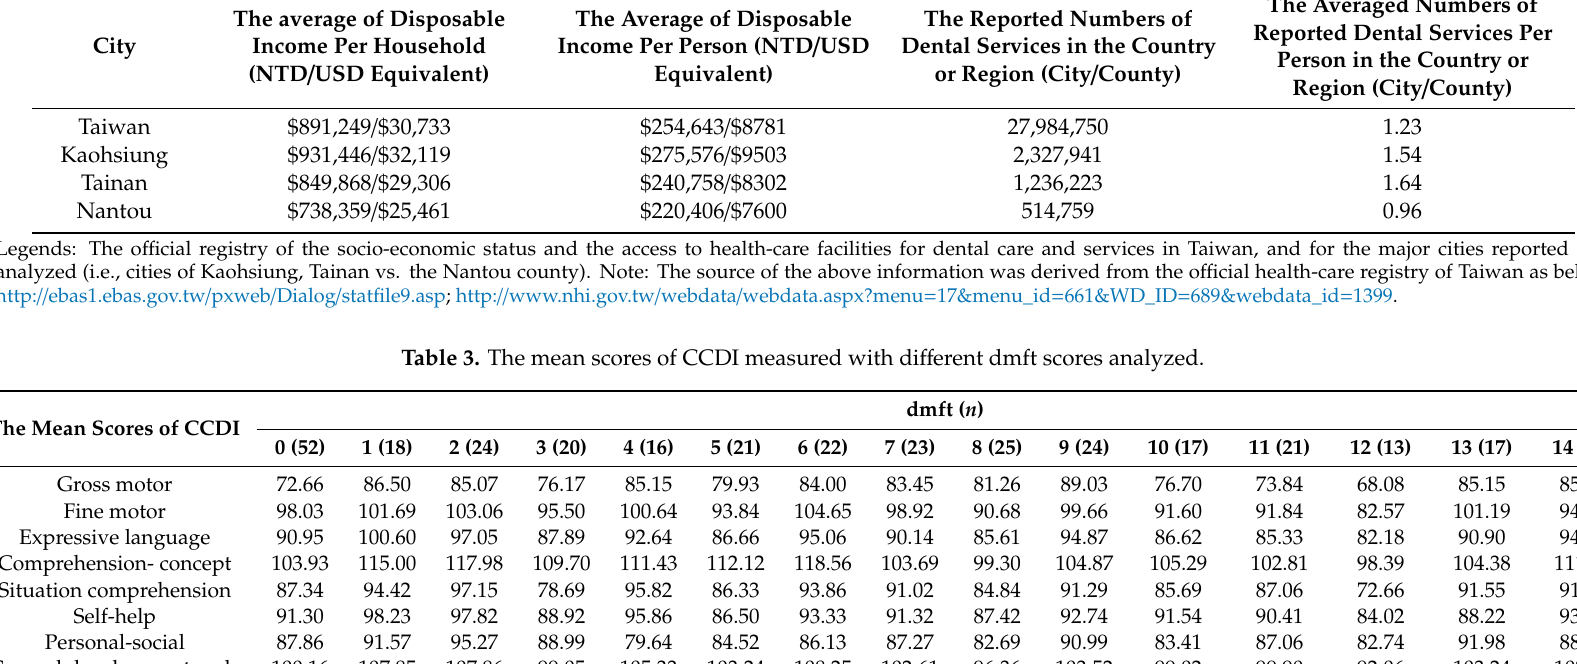
Table 2. The socio-economic status and health-care facilities for dental care-and-services in major cities of Taiwan analyzed. The average of Disposable The Average of Disposable City (NTD / USD Equivalent)